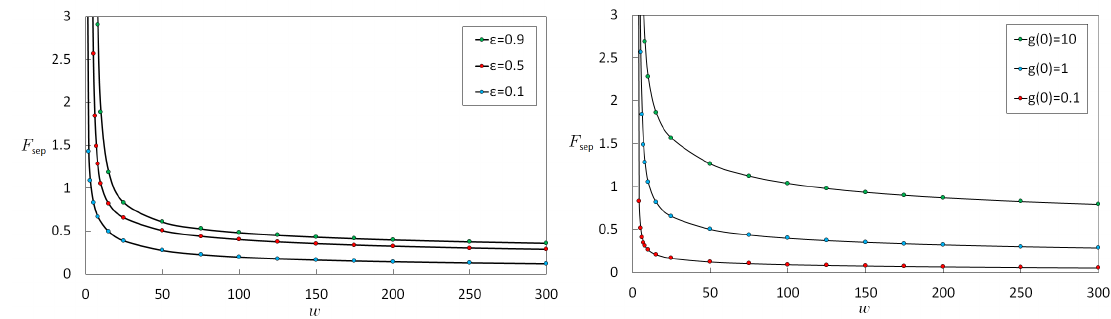
(cid:112) g ( 0 ) D 2 ( 0 ) = 1.